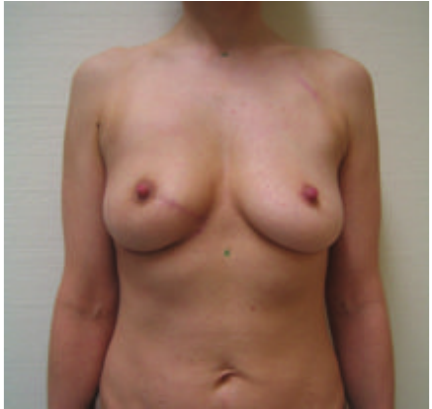
Figure 2: 19-month follow-up; scar length 25 cm; patient was very satisfied with cosmetic result; BCCT.core: good; the scar visibility was rated as slightly visible by the patient and the experts, and the volume discrepancy was rated slight by the patient and not at all by the